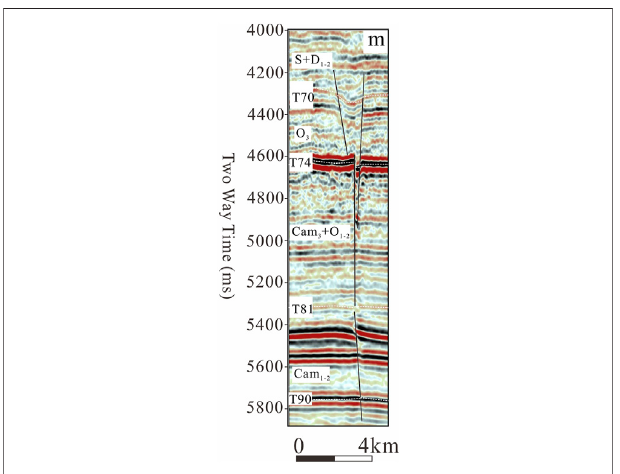
FIGURE8| 3D seismic pro fi le ofatranstensional part ofan R-shear (see Figure 6 for location).